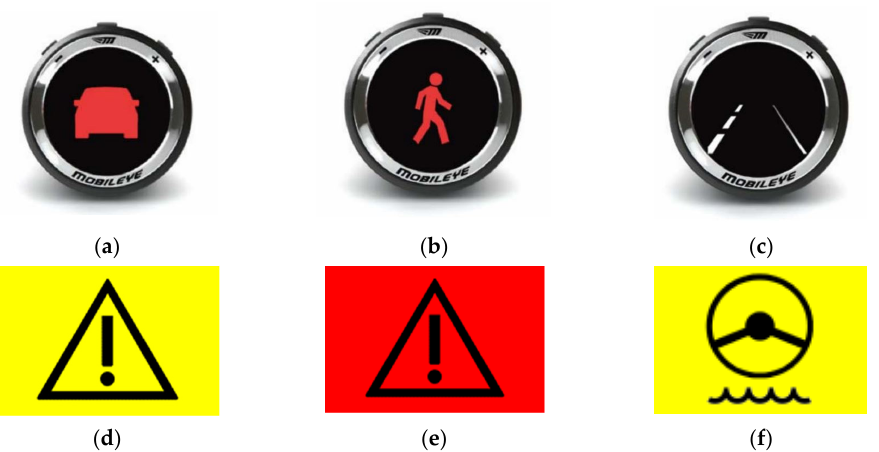
Figure 2. RtI icons tested by Solaris: ( a ) red car icon (MobilEye), ( b ) red pedestrian icon (MobilEye), ( c ) leaving-the-lane icon (MobilEye), ( d ) warning triangle in yellow (Solaris), ( e ) warning triangle in red (Solaris), ( f ) steering wheel in yellow (Solaris).